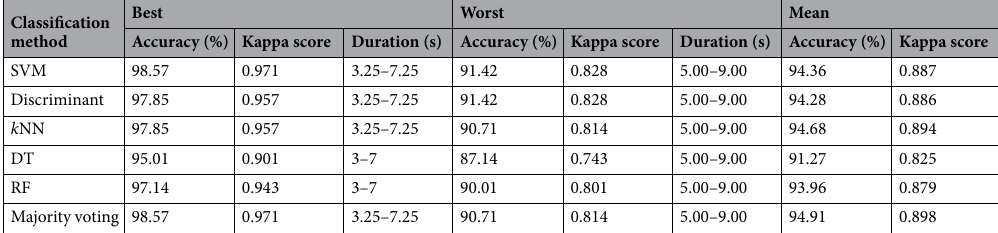
Best Classification method